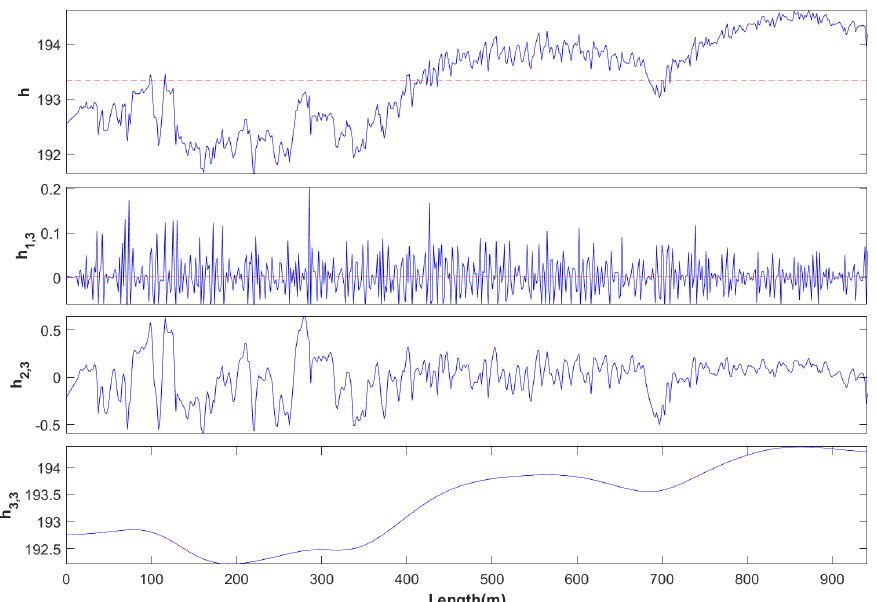
Figure 14. Wavelet analysis for profile N = 26 on 1 February 2018. Flow occurs from left to right. ( a ) Longitudinal bed elevation; ( b ) spatial distribution of wavelengths ( λ ), through wavelet power spectrum contours using the Morlet function; ( c ) global wavelet power spectrum, indicating the main wavelength frequencies.